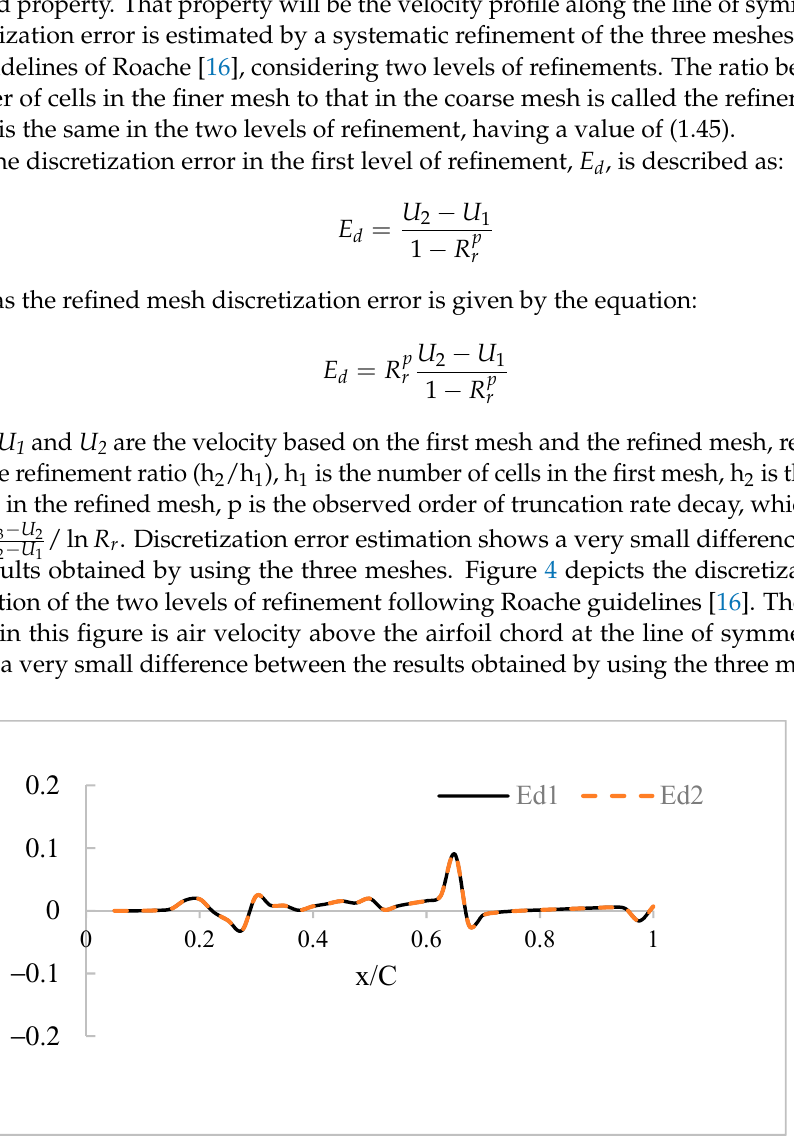
Figure 5. Normalized air velocity profile ( V c /U ∞ ) versus the normalized chord of the airfoil ( x/C ) based on the results from the three meshes at U ∞ = 3.0 m/s and 0.0° angle of attack. A set of two 3D-printed NACA 2424 airfoils with 200 mm chord length and 100 mm span (1:25 scale of the proposed system) was used to validate the CFD model results, Fig- ure 6. Validation is defined as the process of determining the degree to which a model is an accurate representation of the real world from the perspective of the intended uses of the model [17]. The 3D- printed airfoils were covered with smooth glossy paper to mini- mize surface roughness. Based on the selected scale, a 20 mm gap, equivalent to a 50 cm full-scale gap, was chosen for this test. Velocities were tested at 4 locations on the center- line between the airfoils and 60 mm above the bottom surface of the airfoils using a 3 mm diameter pitot-static tube with a mainstream velocity of 10 m/s (Re ≈ 127,000). Velocities were directly measured with EXTECH ® HD350 differential pressure manometer with an accuracy of ±(1%FS) @ 5.00 to 10.00 m/s. The main failing of using Pitot tubes is that their measurement inaccuracy is typically about ±5% [18]. The difference between the meas- ured and the simulated velocity values are shown in Table 3. The difference between the experimental and simulated data was small and did not exceed 8%, which provides enough confidence in the developed CFD model.